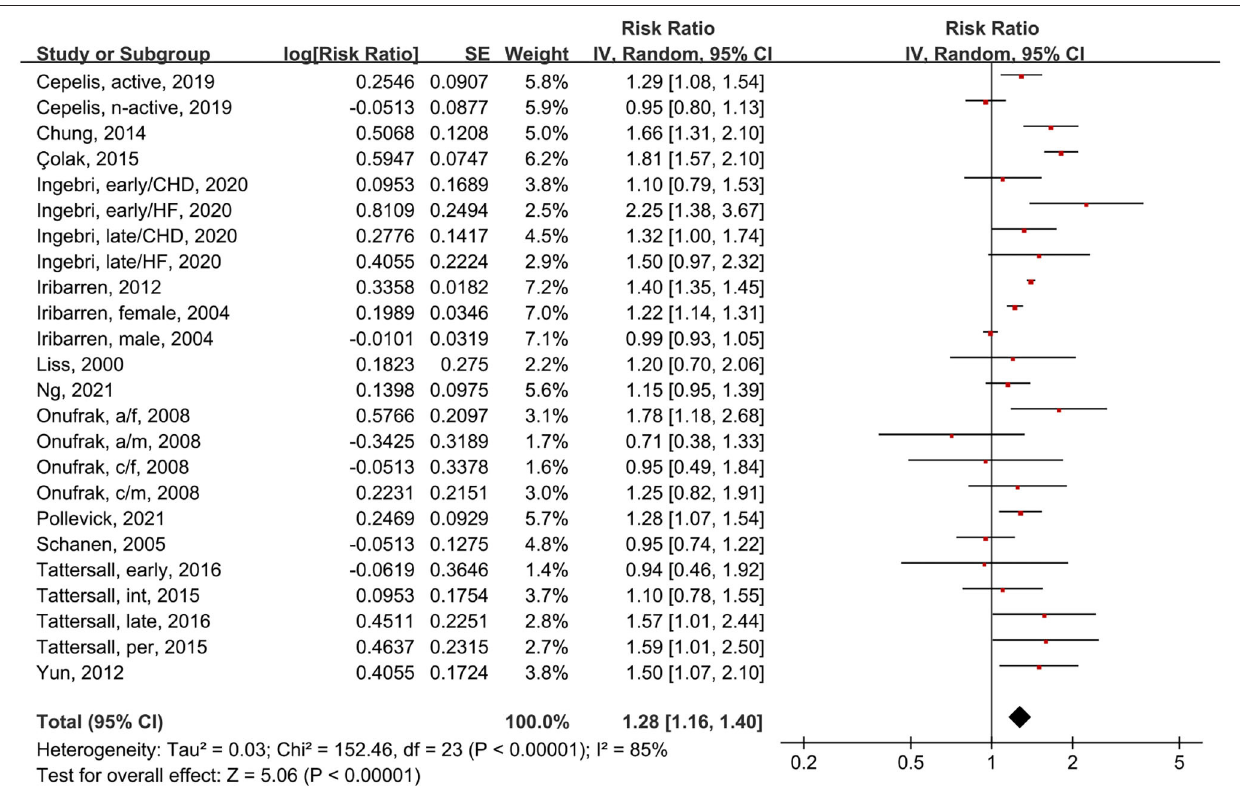
FIGURE 4 | Forest plot shows association between asthma and CVD morbidity. SE, standard error; IV, Inverse Variance method; df, degrees of freedom; HF, heart failure; CHD, coronary heart disease; a/f, adult female; a/m, adult male; c/f, child female; c/m, child male; int, intermittent; per, persistent.